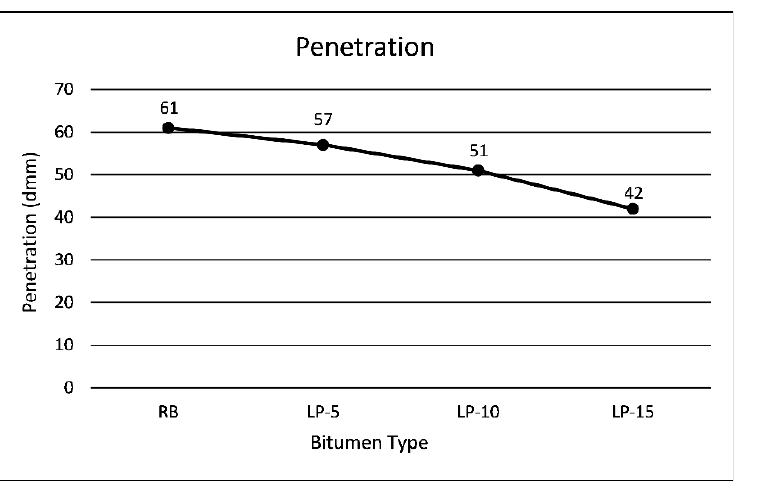
Figure 11. Change in penetration with respect to reference bitumen . 3.2. Softening Point Test The softening point test was carried out with respect to the EN 1426 specification. Figure 12 shows the results of the softening point test.